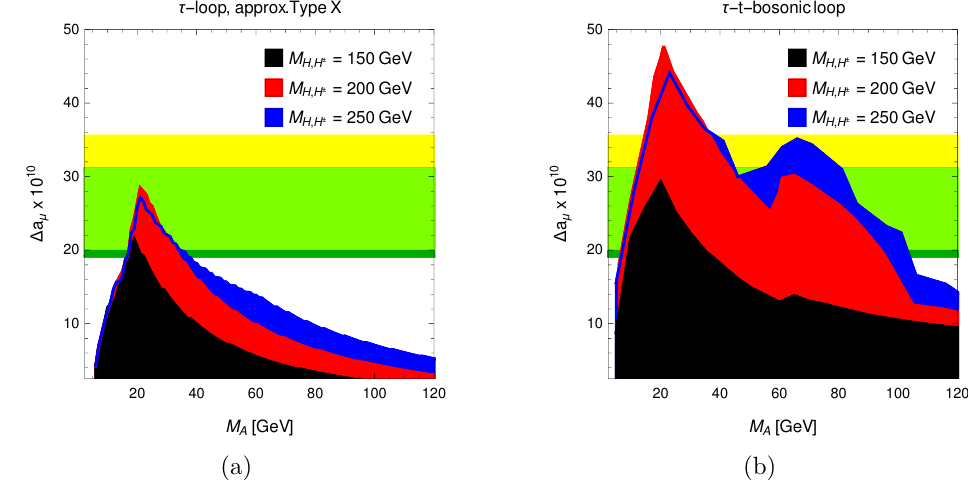
Figure 1. The maximum results for ∆ a µ in the two versions of the two-Higgs Doublet Model with minimal flavour violation, compared with the 1 σ regions around ∆ a BNL (yellow) and new world µ average ∆ a 2021 (green); light green shows the overlap between the two regions. The maximum µ results are shown as functions of M , for three different values of M , as indicated: (a) lepton- A H,H ± specific/type X model (b) flavour-aligned two-Higgs Doublet Model. The results are based on ref. [252]. The left plot is technically obtained in the framework of the flavour-aligned model but taking only τ -loop contributions, which coincides with the type X